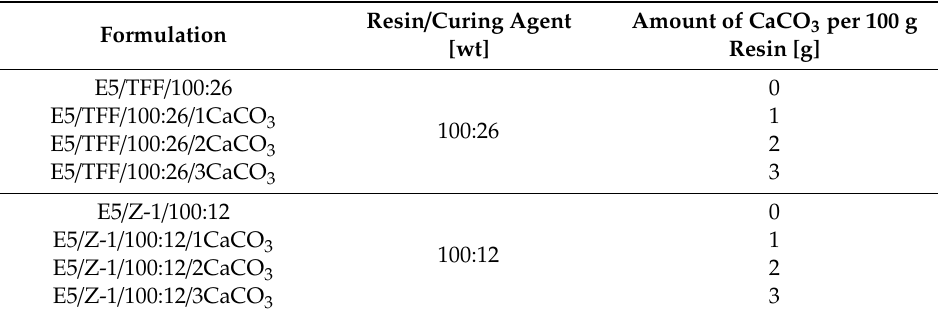
Table 4. Different, control and modified with calcium carbonate, epoxy compounds produced and analysed in the present study.